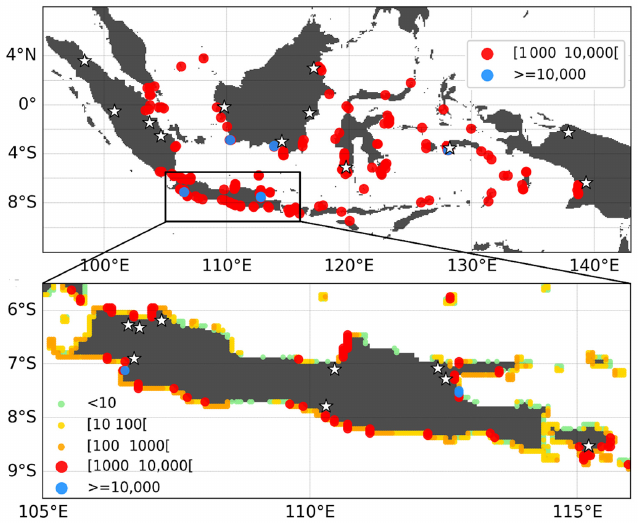
Figure 4. Locations of stranded particles along Indonesian coasts. White stars indicate the riverine sources. The upper panel shows locations where more than 1000 and more than 10,000 particles were stranded on the same coastal numerical segment 5 km in length. The lower panel focuses on the islands of Java and Bali.